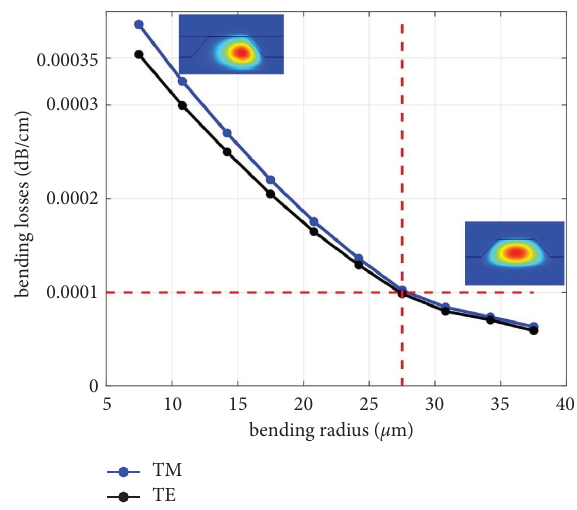
Figure 6: Simulated bending loss as a function of bending radius for TE and TM modes from 6 to 37.5 μ m. At a radius of 6 μ m, all the mode power radiates from the core. At 37.5 μ m, losses are quite similar to those in a straight waveguide. Modes were calculated at a wavelength of 1570nm. TM mode profles are included in the fgure for bending radii of 6 and 37.5 μ m . Table 3: Mode analysis simulation results on optimal dimensions of the cross-section and an optimal material system enabling athermal and polarization-insensitive behavior of the device.